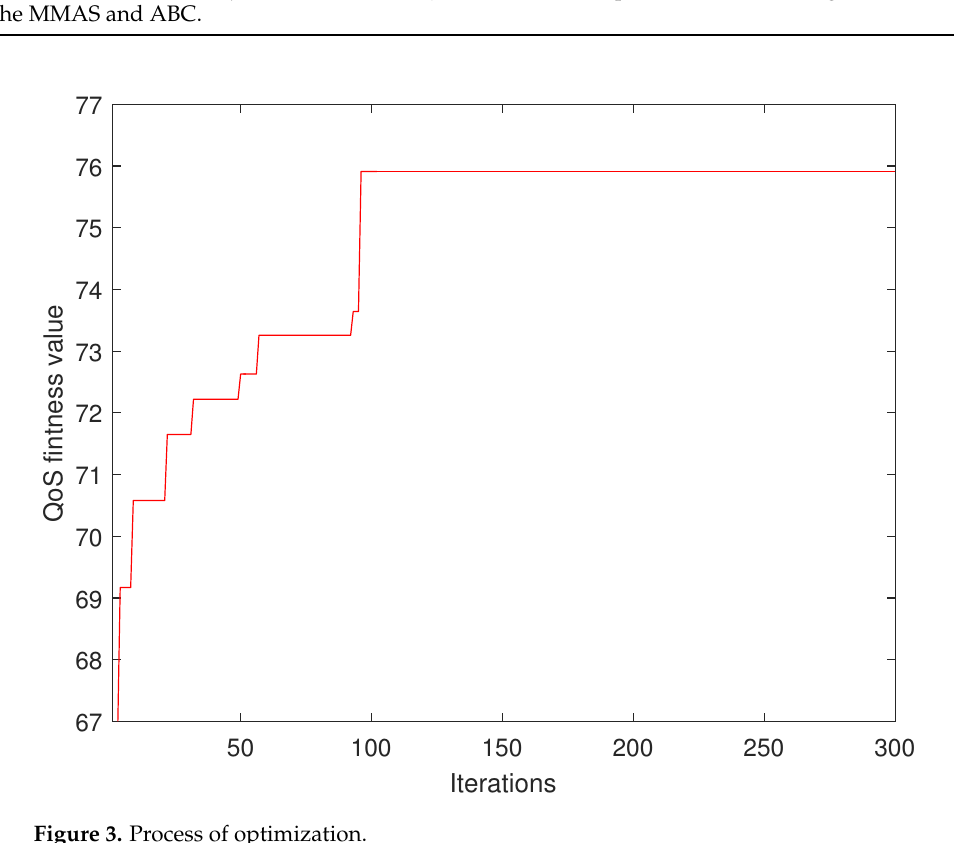
Figure 3. Process of